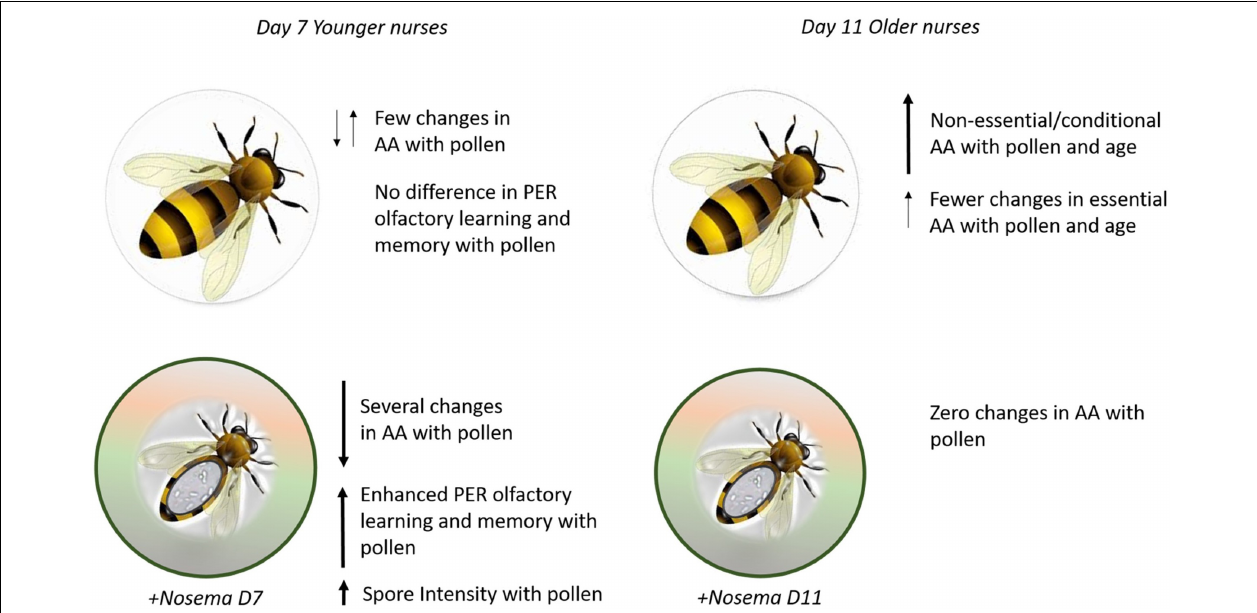
FIGURE 5 | Summary figure. (Top) Bees fed pollen showed few changes in amino acids (AA) and no difference was found in olfactory learning and memory performance on Day 7. By Day 11, pollen-fed bees show higher levels of (AA) in the brain, especially in non-essential amino acids. (Bottom) Nosema -infected bees show a different profile with pollen. At Day 7, several AA in the brain are affected by pollen in addition to enhanced olfactory learning and memory behavior and spore intensity. By Day 11, pollen does not affect AA.